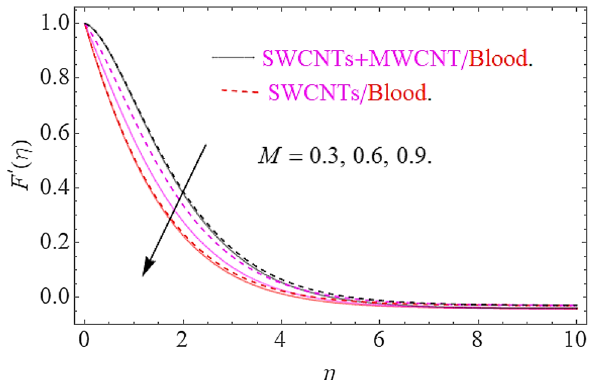
Figure 3. Impact of M on F ′ (η) .